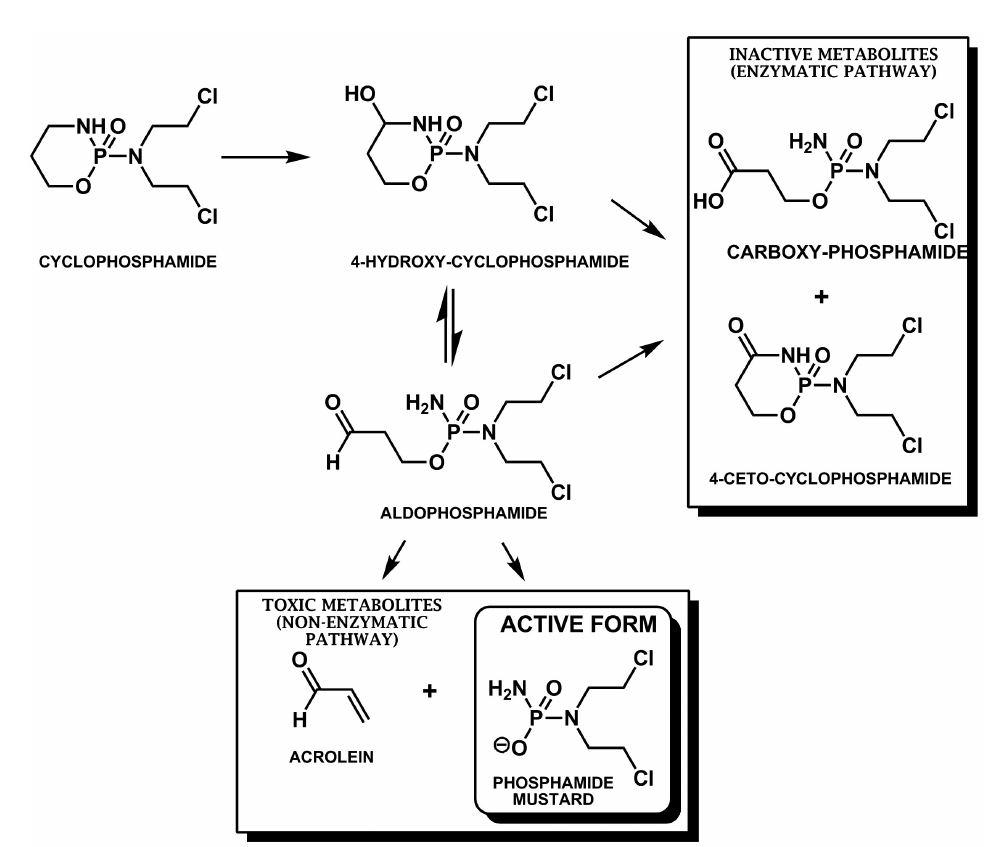
FIGURE 13 - Diagram of cyclophosphamide bioactivation